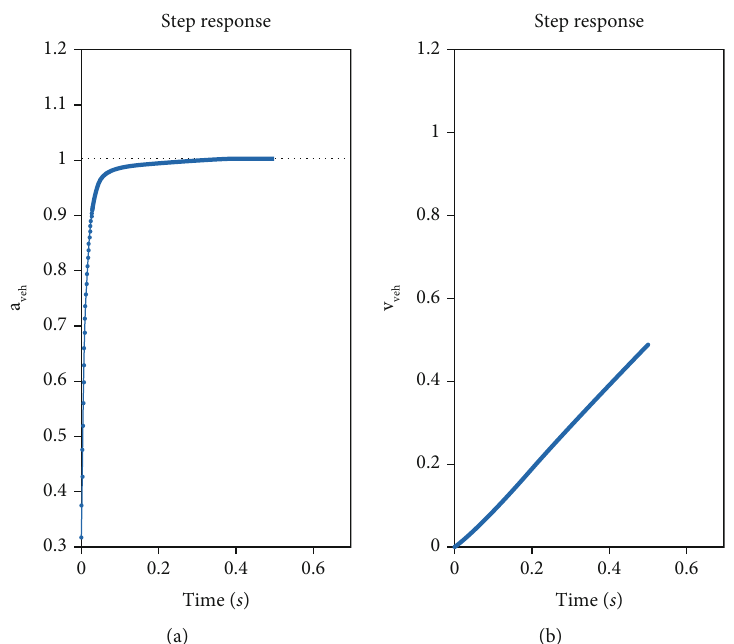
Figure 14: Vehicle acceleration (a) and speed (b) responses, respectively, in PID-CHR (20%) (1).